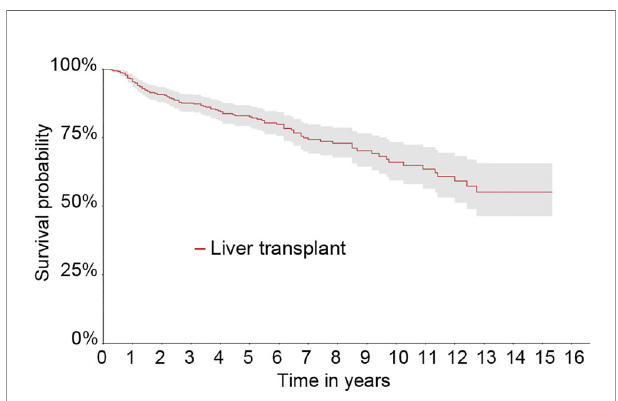
FIGURE 4 | Kaplan-Meier survival curve of the liver graft from 2000 to 2015 in the Matched cohort.